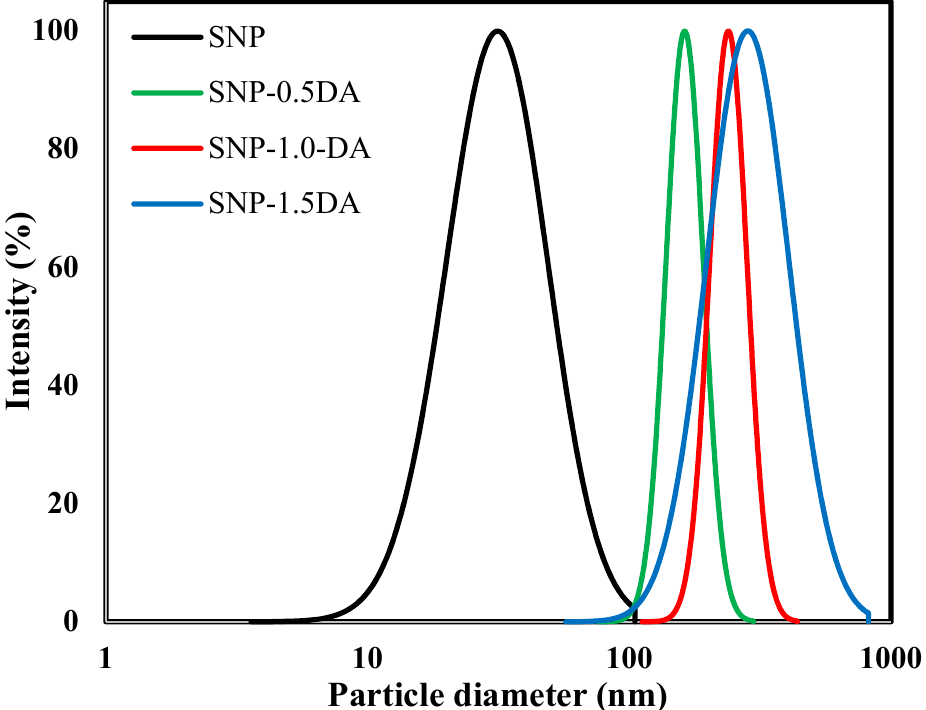
Figure 3. TGA profile for the four nanocomposites over the temperature range of 20–600 °C.